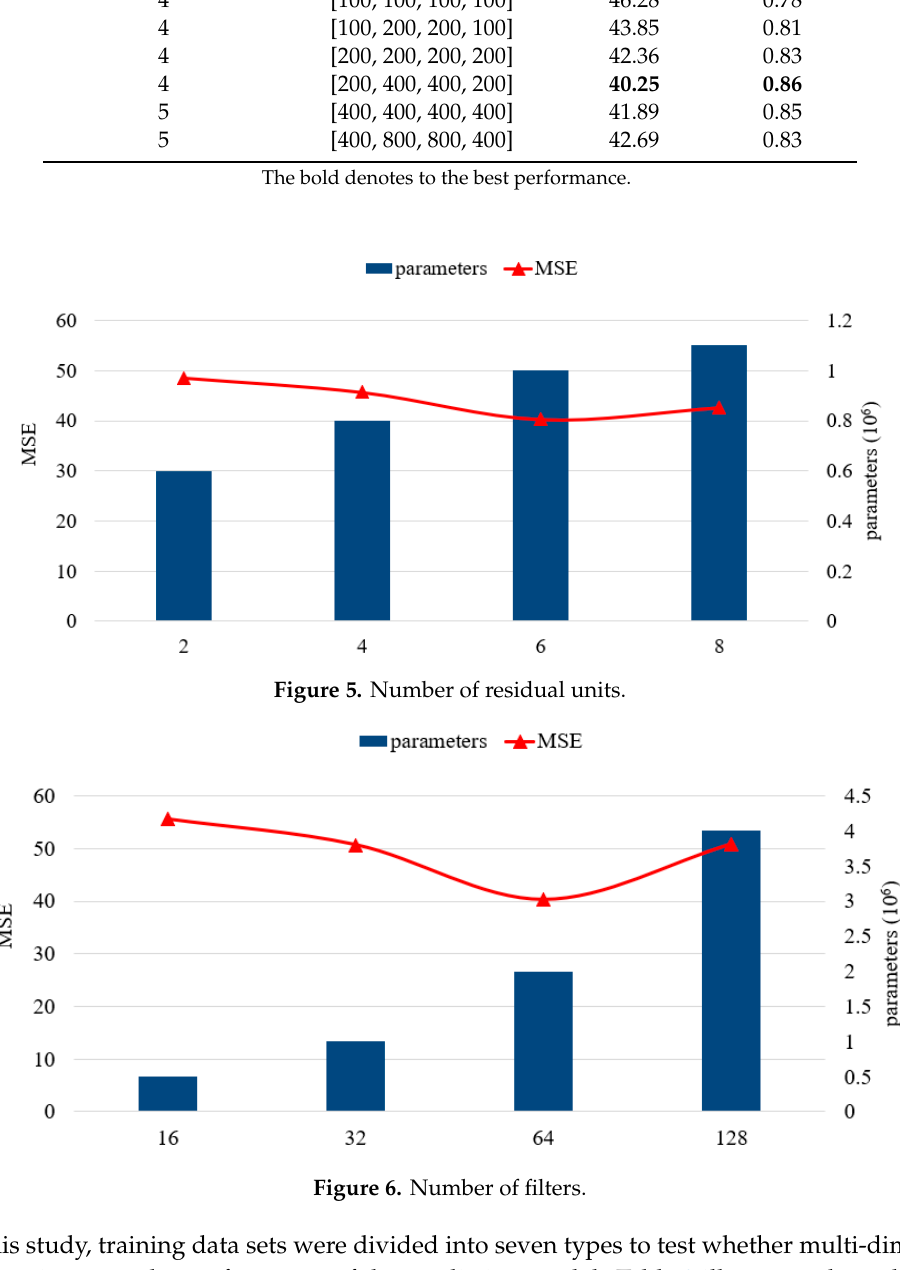
Table 3. Performance comparisons of the 7 train datasets.